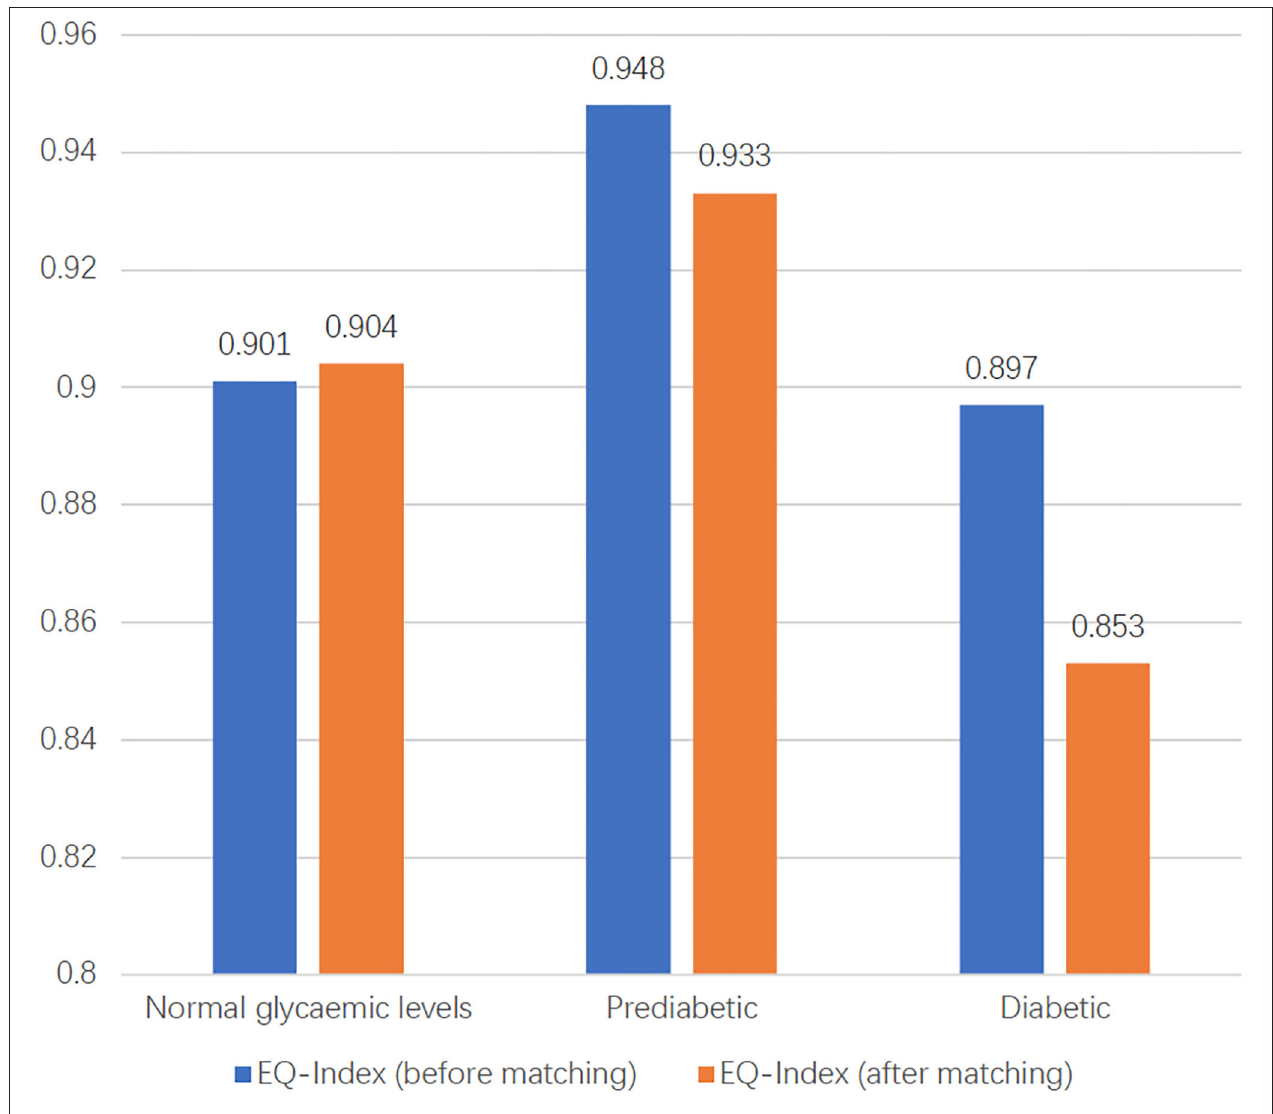
FIGURE 3 | The distribution of EQ-Index of three groups before and after matching.